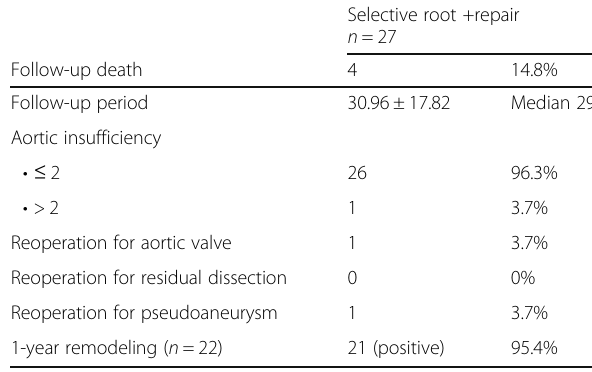
Table 5 Postoperative follow-up